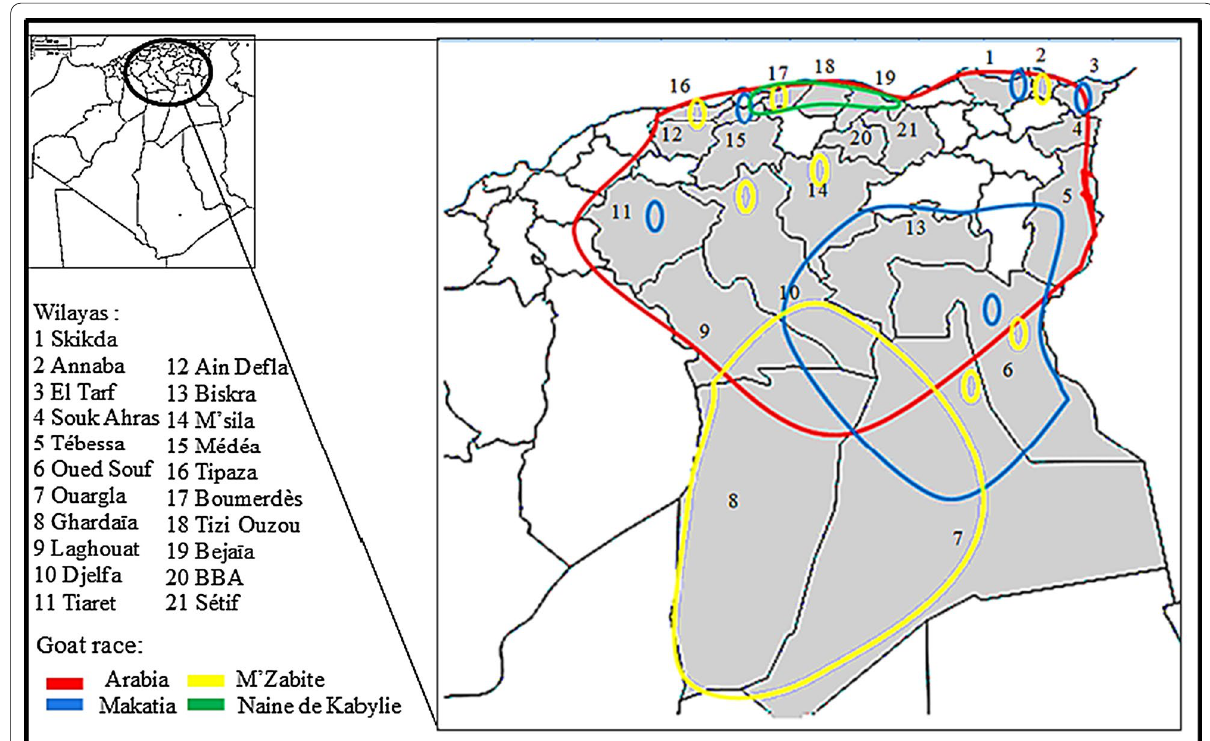
Fig. 1 Presentations of the study regions and the range of the different goat